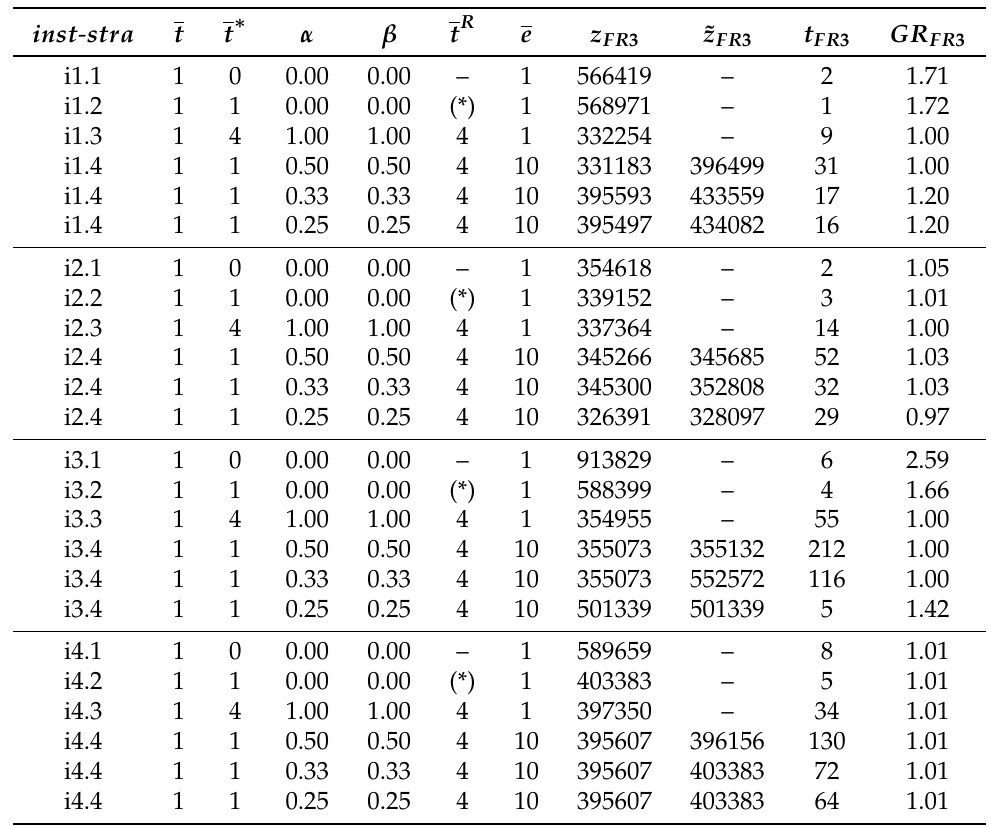
Table A1. S-HUB-NEP model (1)–(30). SFR3 matheuristic. Strategies’ results. inst -